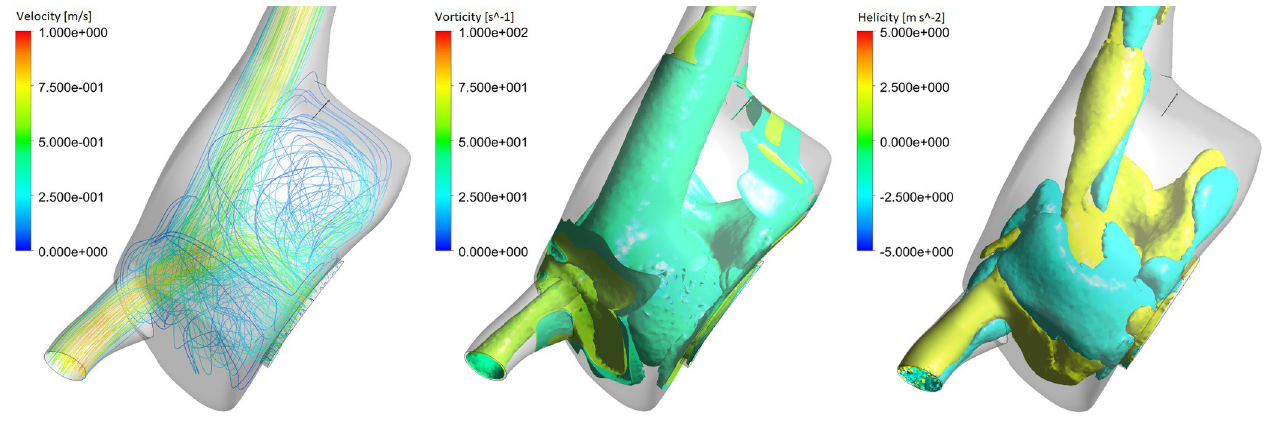
Fig 10. Right atrial flow patterns: Streamline fields representing velocity magnitude are presented (left), as well as isosurfaces representing vorticity (middle) and helicity (right), at the beginning of systole (t = 0.25 s).